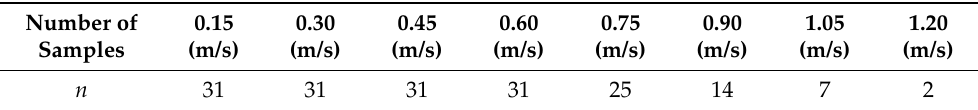
Table 1. Number of samples at each stage. When the velocity (m/s) reaches the critical swimming speed, the number of samples naturally